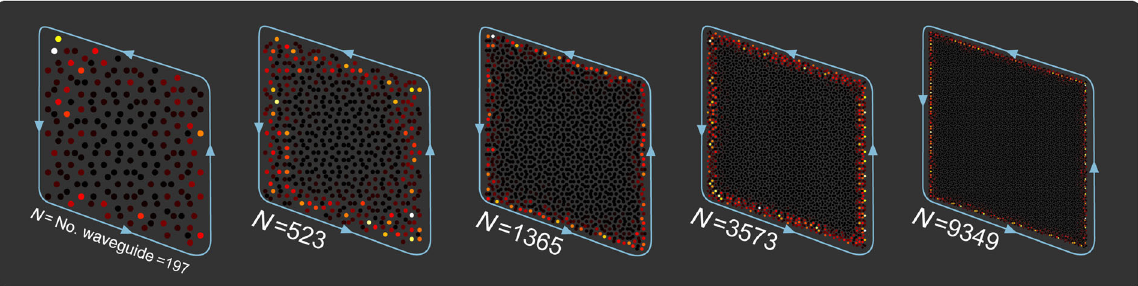
FIG. 5. Topological edge states associated with the topological band gap depicted in Fig. 4(d), for increasing size of the quasicrystal. The energy flow is always unidirectional as indicated by the blue lines.